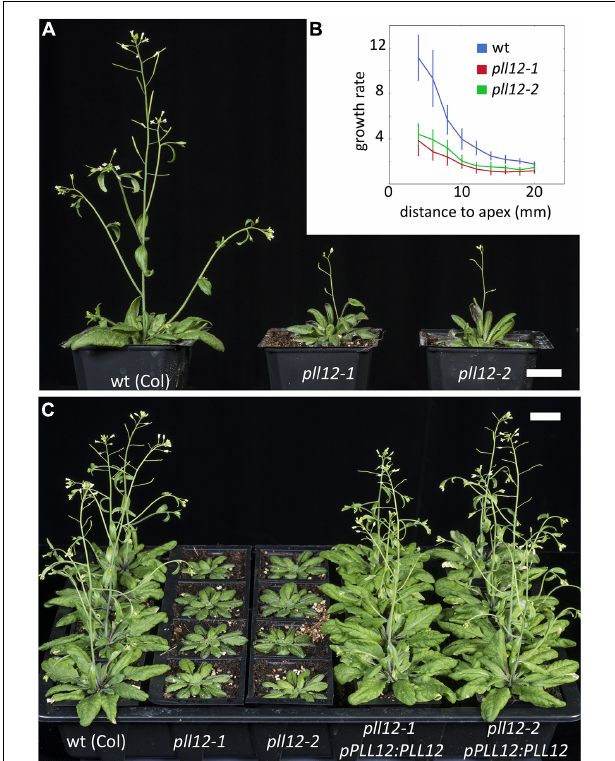
FIGURE 2 | pll12 mutants have reduced growth and slow stem elongation. (A) : Adult wild type (Col-0) and two different pll12 mutant alleles grown side by side for 40 days. Both mutant lines bolted late and produced slow growing stems with few lateral organs. Scale bar: 2 cm. (B) : Relative growth rate (fold increase in length over 4 days) in Col-0 and pll12 mutants measured at different starting positions along the stem. The stem elongates faster nearer to the apex and in the mutants this differential growth was significantly reduced. (C) : A genomic pPLL12:PLL12 construct transformed into both mutant lines rescued the wild type phenotype. Scale bar: 2